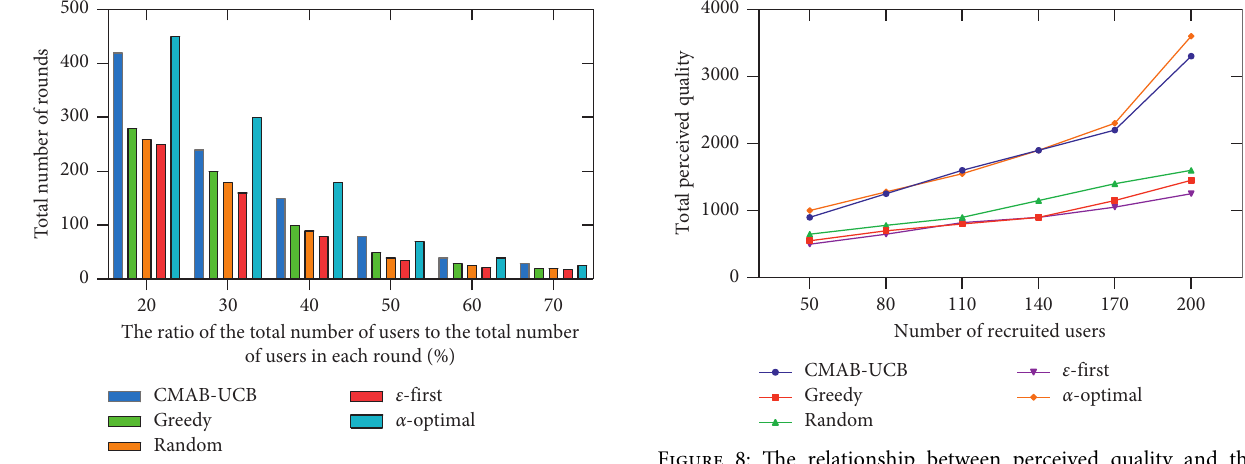
Figure 5: The relationship between total rounds and user re- cruitment in each round ( b � 5000).